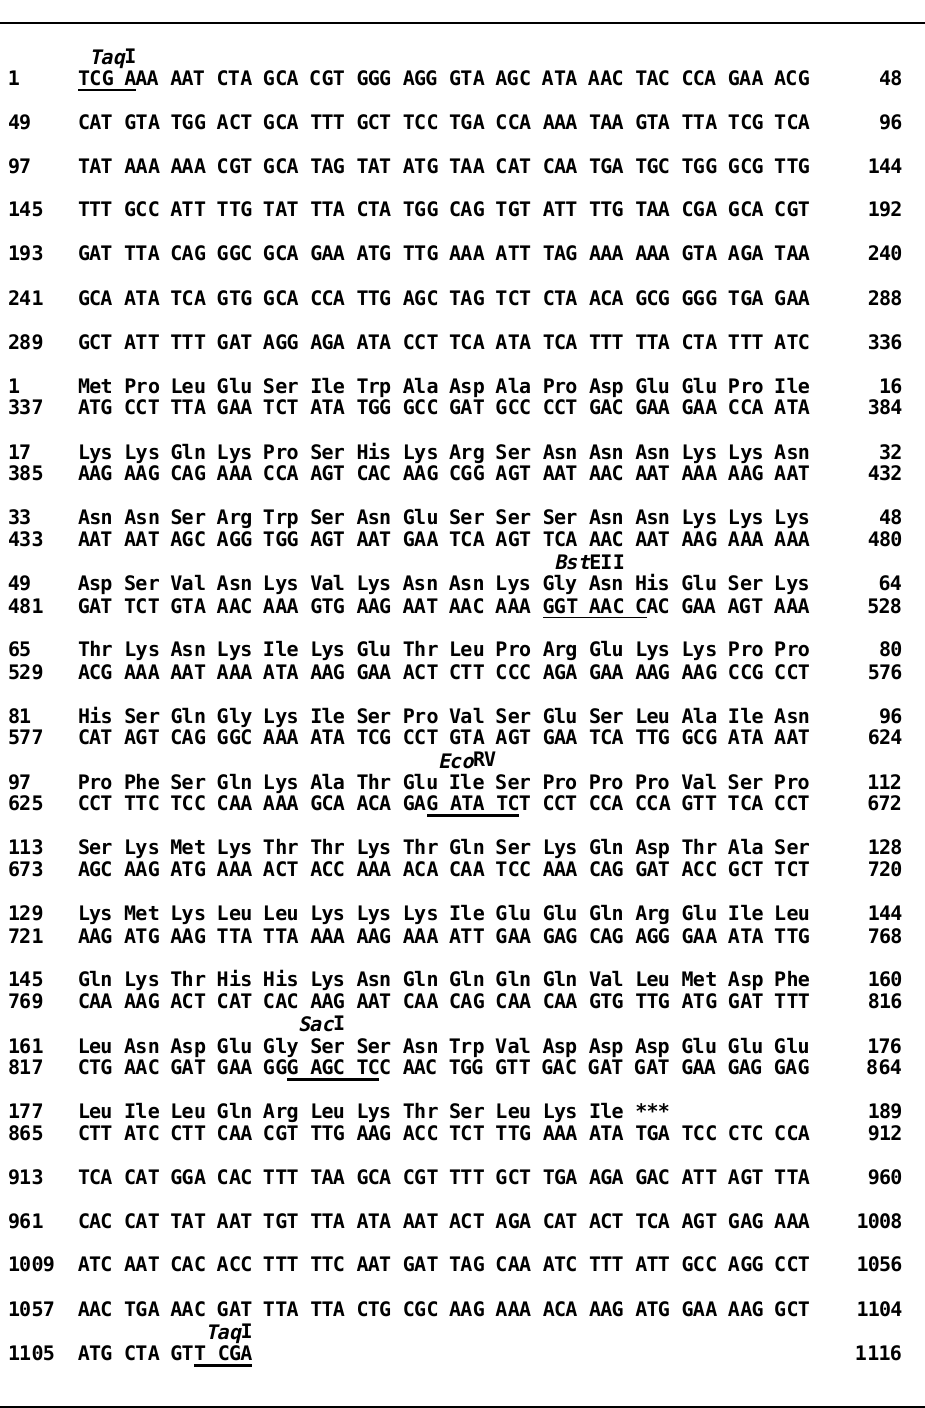
Figure 2 - Nucleotide sequence of YMR255W and flanking re- gions. The sense DNA strand from the Taq I fragment (pG199/ T8) and the translated reading frame corresponding to YMR 255W are shown (GenBank ac- cession number AF007064). Re- striction enzyme sites used for cloning, disruption and probe preparation are